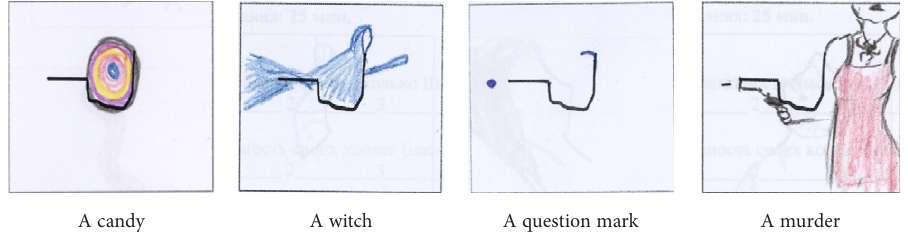
Figure 7. The creative task: interpretation of Fragment 1 – exceptional images (source: testingmom.com,